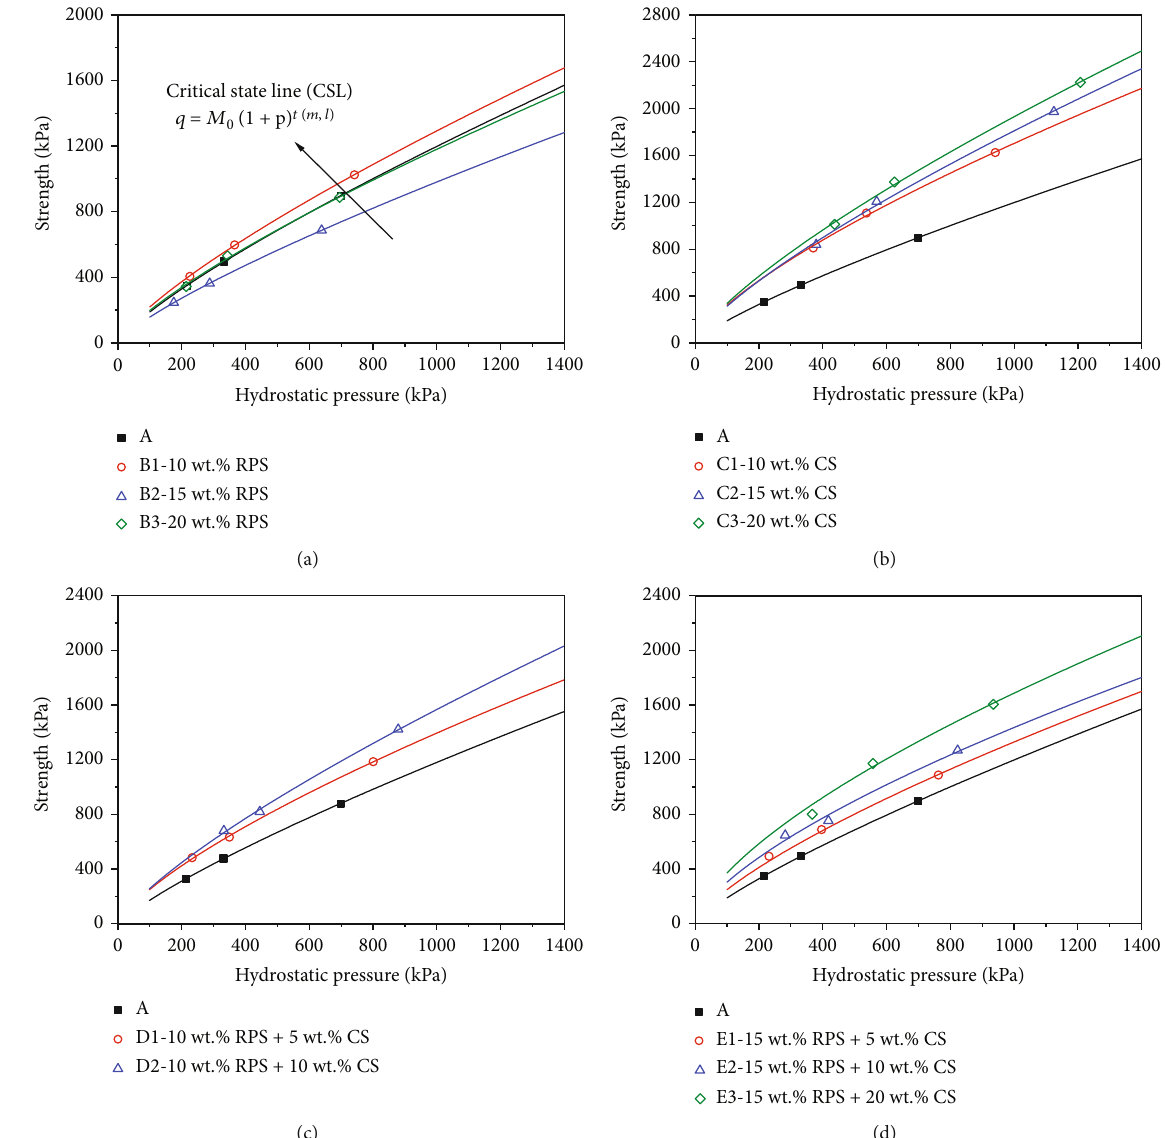
Figure 7: Critical state lines of modi fi ed soils: (a) the red Pisha sandstone modi fi ed soils; (b) the carbide slag modi fi ed soils; (c) the red Pisha sandstone and carbide slag modi fi ed soils; and (d) the red Pisha sandstone and carbide slag modi fi ed